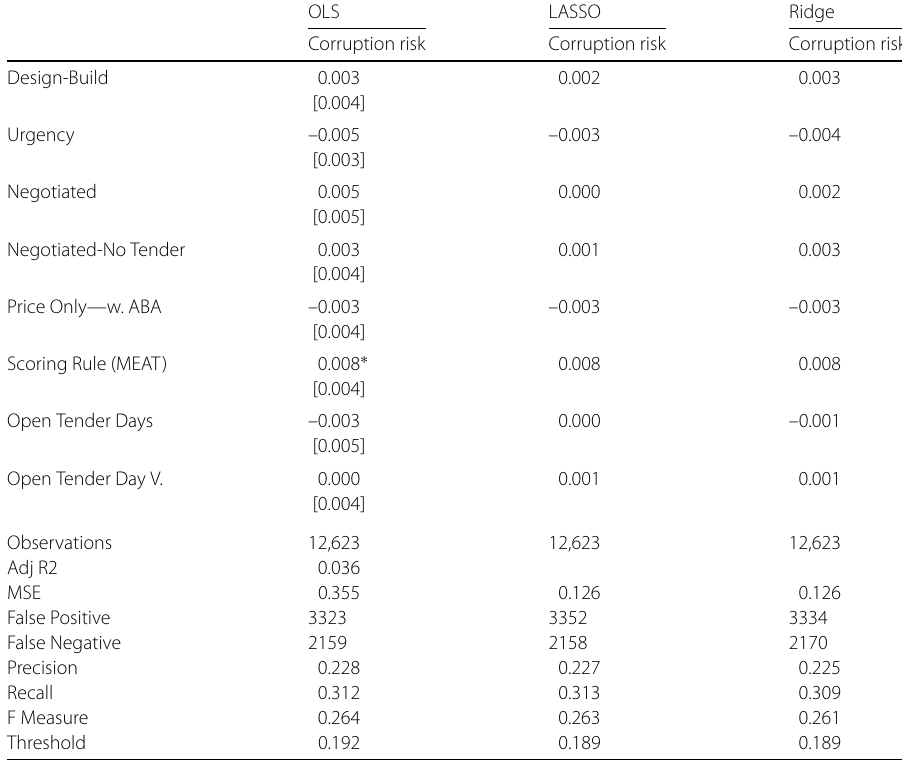
Table 6 Estimates for the small model—main data OLS LASSO Ridge Corruption risk Corruption risk Corruption